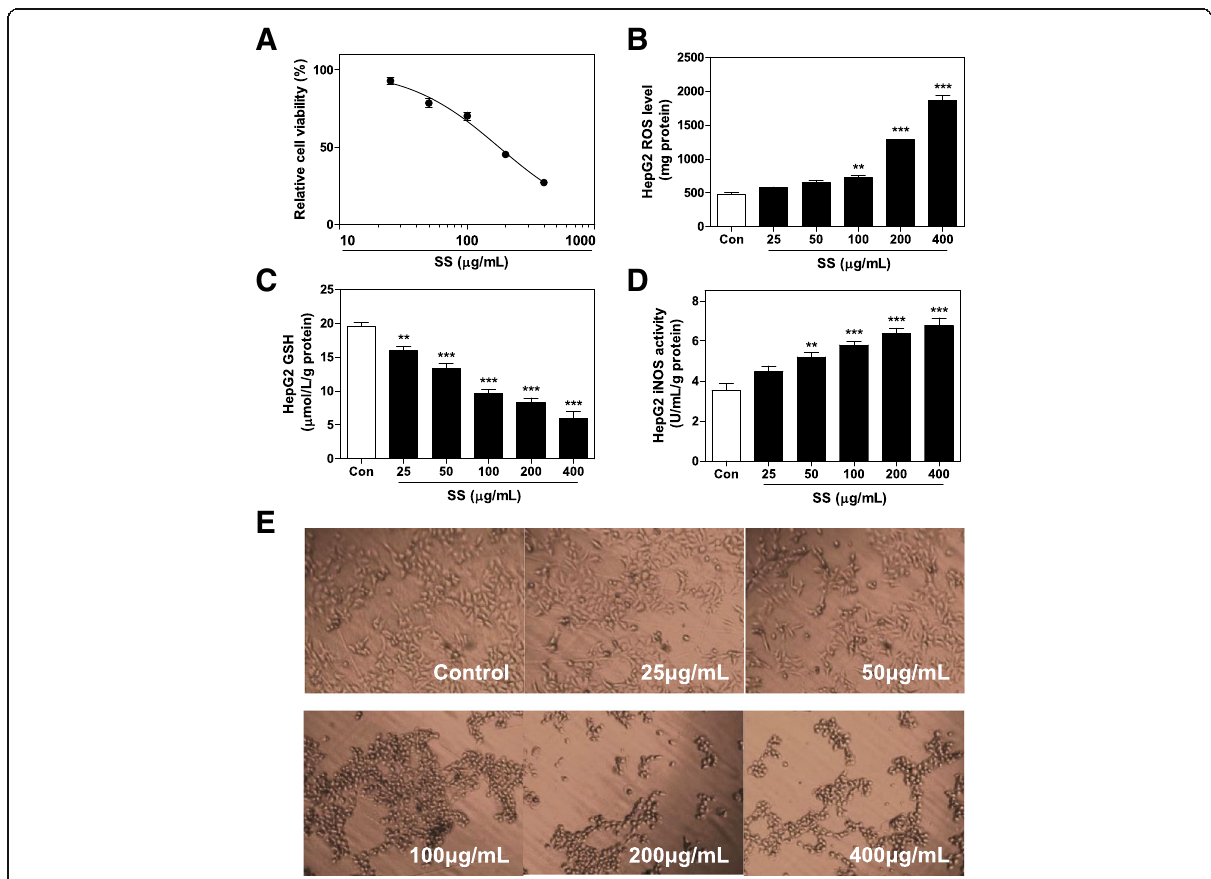
Fig. 8 Effects of SS on HepG2 cells. a Effects of SS on cell viability of HepG2 cells after 24 h treatment. Effects of 12 h treatment of SS on b ROS, c GSH and d iNOS level in HepG2 cells. e Effects of SS on morphology changes of HepG2 cells after 12 h treatment. All results are presented as mean ± S.E. ( n = 3), **p < 0.01 , ***p < 0.001 , compared to vehicle control